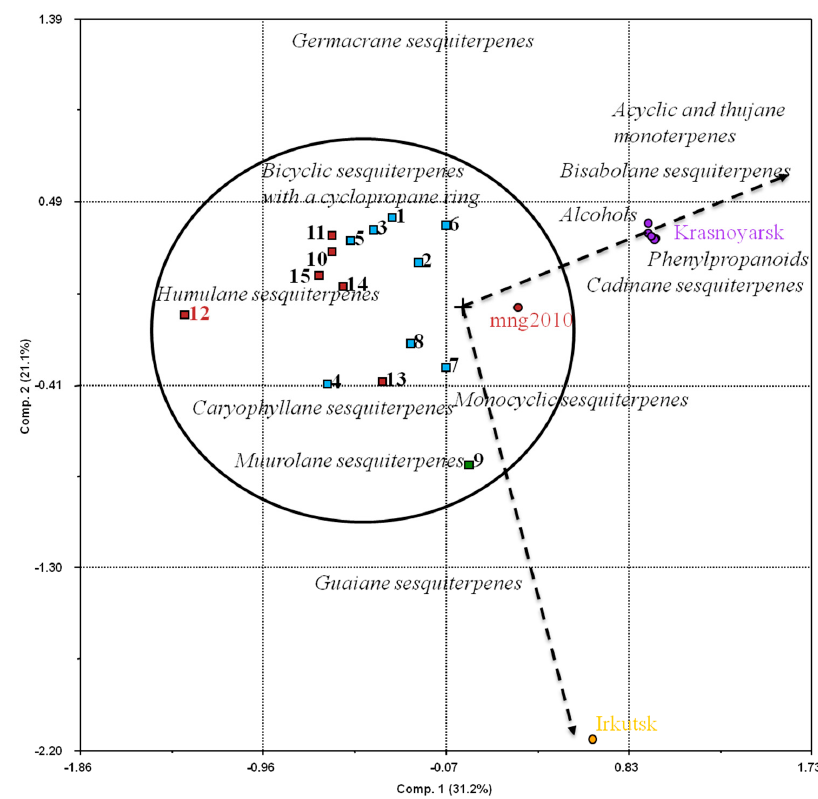
Figure 1. Principal component analysis biplot of essential oil components from B. scorzonerifolium samples collected from different regions. Numerals indicate own data (Table 1). Light-blue-filled quadrants indicate samples from Buryatia (Russia), green-filled quadrant is the sample from the Trans–Baikal region (Russia), brown-filled quadrants are the samples from Khentii aimag (Mongolia). Brown-filled circle (mng2010) is according to [10]. “Irkutsk” indicates the B. scorzonerifolium sample from the Irkutsk region (Russia) according to [9]. “Krasnoyarsk” indicates the B. scorzonerifolium sample from the Krasnoyarsk region (Russia) according to